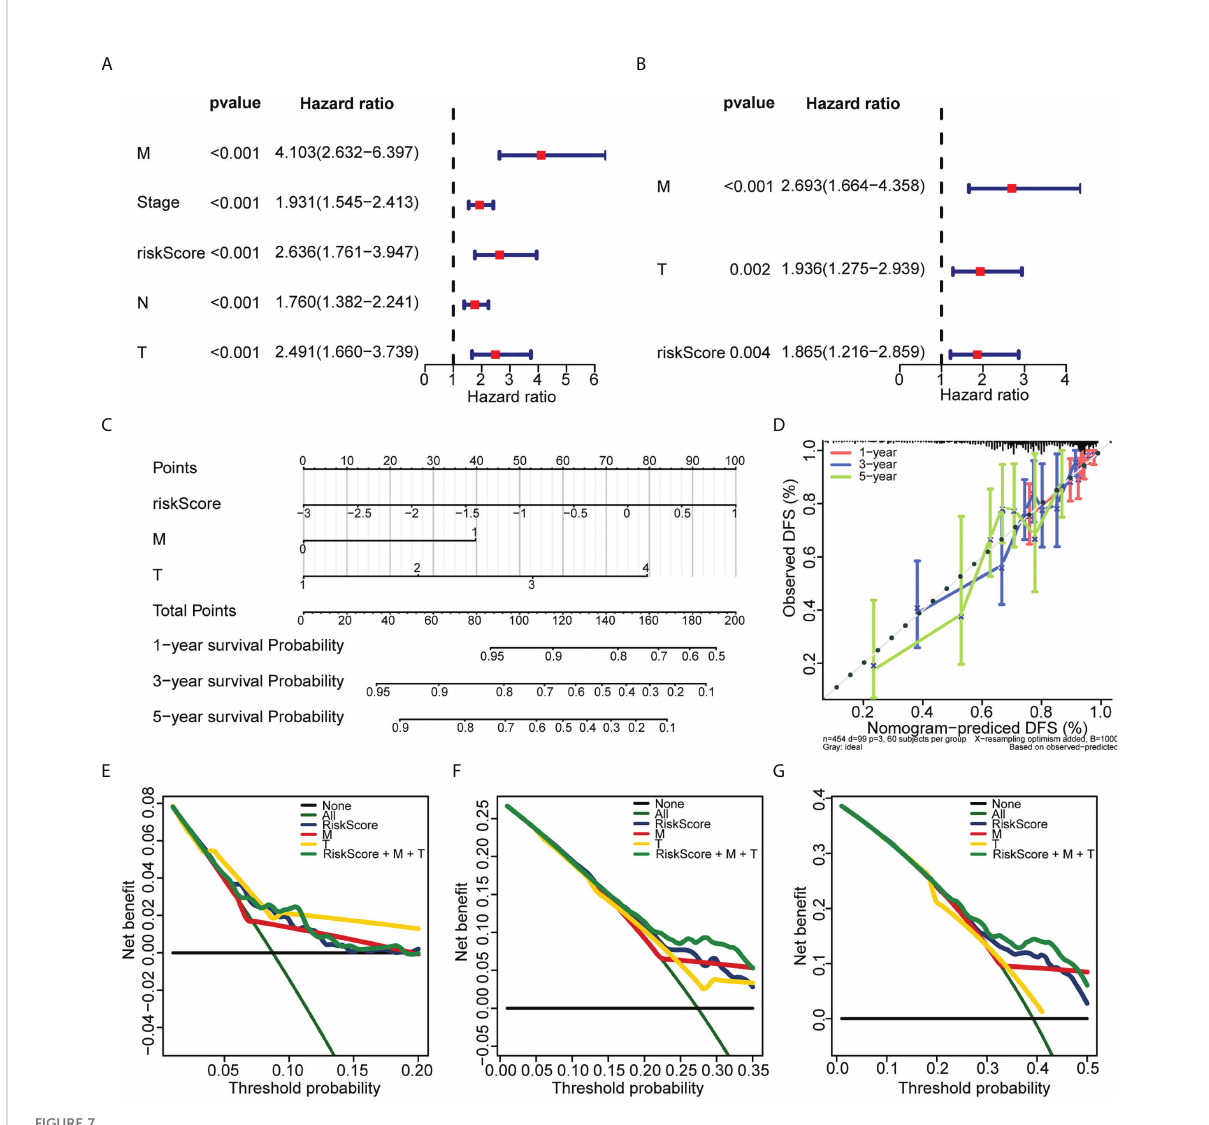
FIGURE 7 Establishment of the nomogram used for predicting the prognosis of CRC patients. (A) Univariate Cox regression analysis of the risk score and clinical variables of CRC patients in TCGA. (B) Multivariate Cox regression analysis of the risk score and clinical variables of CRC patients in TCGA. (C) The nomogram was constructed based on T, M, and risk score. (D) The calibration plots of the nomogram for predicting the 1-, 3-, and 5-year overall survival. (E, F, and G) The decision curves for 1 (E) , 3 (F) , and 5 years (G)